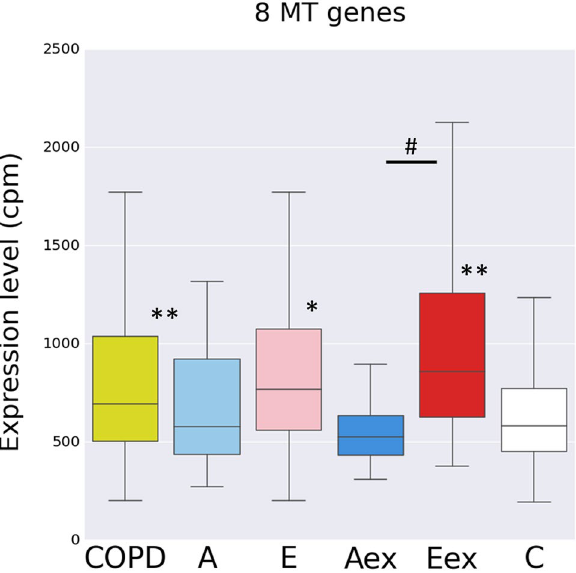
Figure 2. Gene expression level for eight genes encoded by the mitochondrium across all subgroups Shown is a box plot with median, upper and lower quartile and upper and lower whiskers for the sum of the expression level for the eight genes (MT-ND1,2,3,5, MT-CO1,2,3, MT-ATP6), Controls versus cases * p < 0.005; ** p < 0.001; Eex versus Aex # p < 0.005, Wilcoxon rank sum test. COPD is all cases combined: E + A + mix + normal-CT. The figure was produced using the R package ggplot2 (Wickham H (2016). ggplot2: Elegant Graphics for Data Analysis . Springer-Verlag New York. ISBN 978-3-319-24277-4, https:// ggplo t2. tidyv erse.